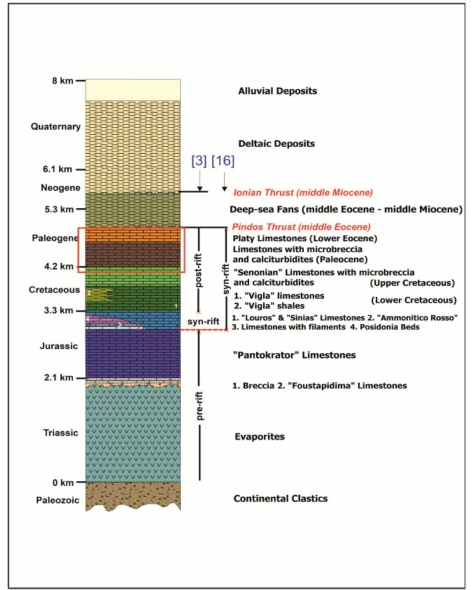
Figure 2. Synthetic lithostratigraphic column of the Ionian zone, NW Greece ([3,16,17]). Red square indicates the range of the studied stratigraphic column. A (Zelilidis et al. [3]) and B (Bourli et al. [16]) refer to the two works on which the starting point of the Ionian Thrust was based on.Specifically, the Ionian basin is part of the external Hellenides orogeny, bounded westwards by the Pre-Apulian platform and eastwards by the Gavrovo platform [2,3,26–29] (Figure 1). The Pre-Apulian zone to the west of the Ionian basin is regarded as the eastern margin of the Apulian platform, in Albania, Croatia and Italy [3,5,30,31]. The sedimentation of the Ionian basin, according to the new models of evolution, is sub-divided into two different stages [16,17]: (i) the pre-rift stage during the Triassic and Early Jurassic, and (ii) the syn-rift stage during the Middle Jurassic to early